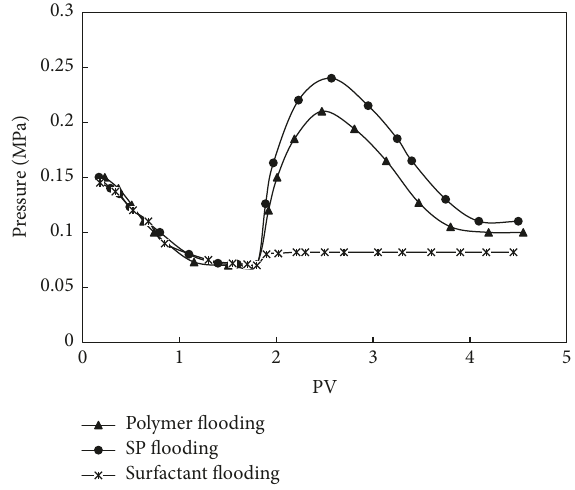
Figure 11: Relationship between inject pressure of different agent and pore